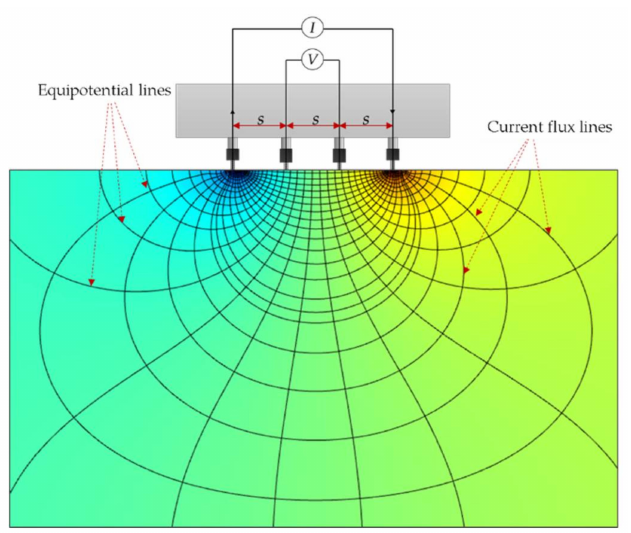
Figure 1. Wenner probe configuration, with ‘s’ as the distance between the